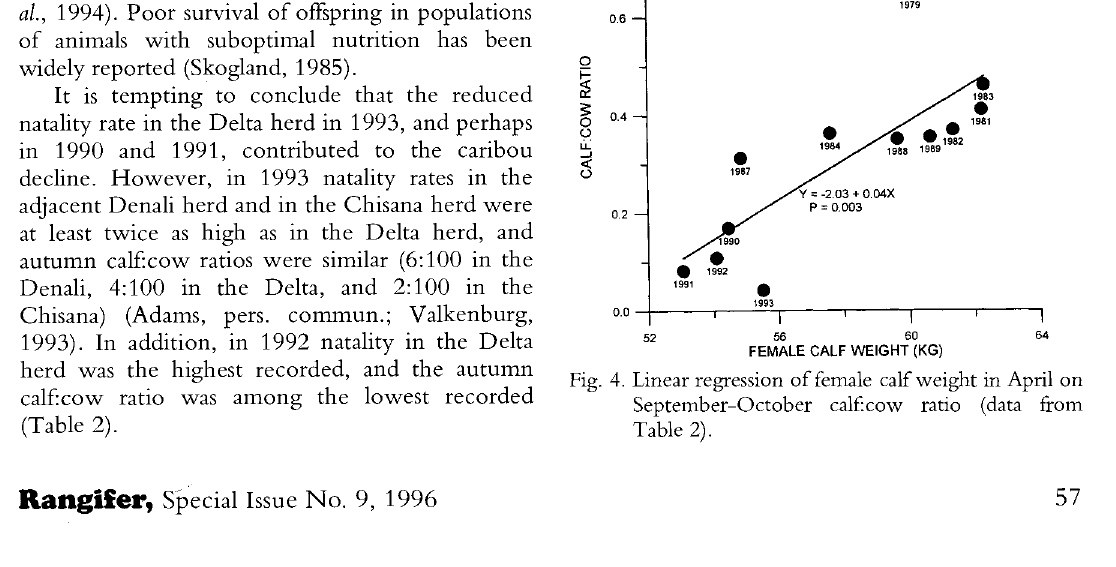
Fig. 4. Linear regression of female calf weight in April on September-October calfxow ratio (data from Table